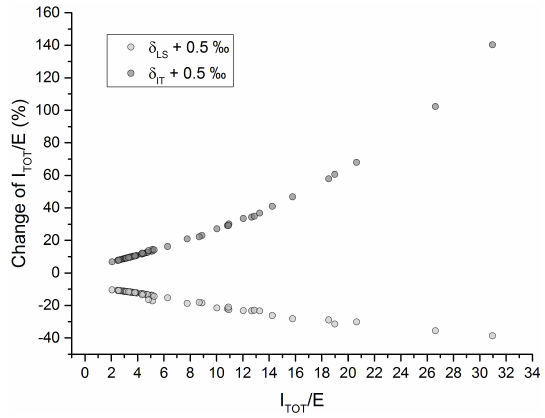
Figure 9. Changes of the total inflow-to-evaporation ratio (in %) based on 18 O isotope mass balance as a function of I TOT /E value, in response to parameter change, calculated for the studied lakes on the Rokua esker. Two cases are considered: (a) an increase of the measured δ 18 O of lake water by 0.5‰, and (b) an increase of δ 18 O of the total inflow to the given lake by 0.5‰. See text for